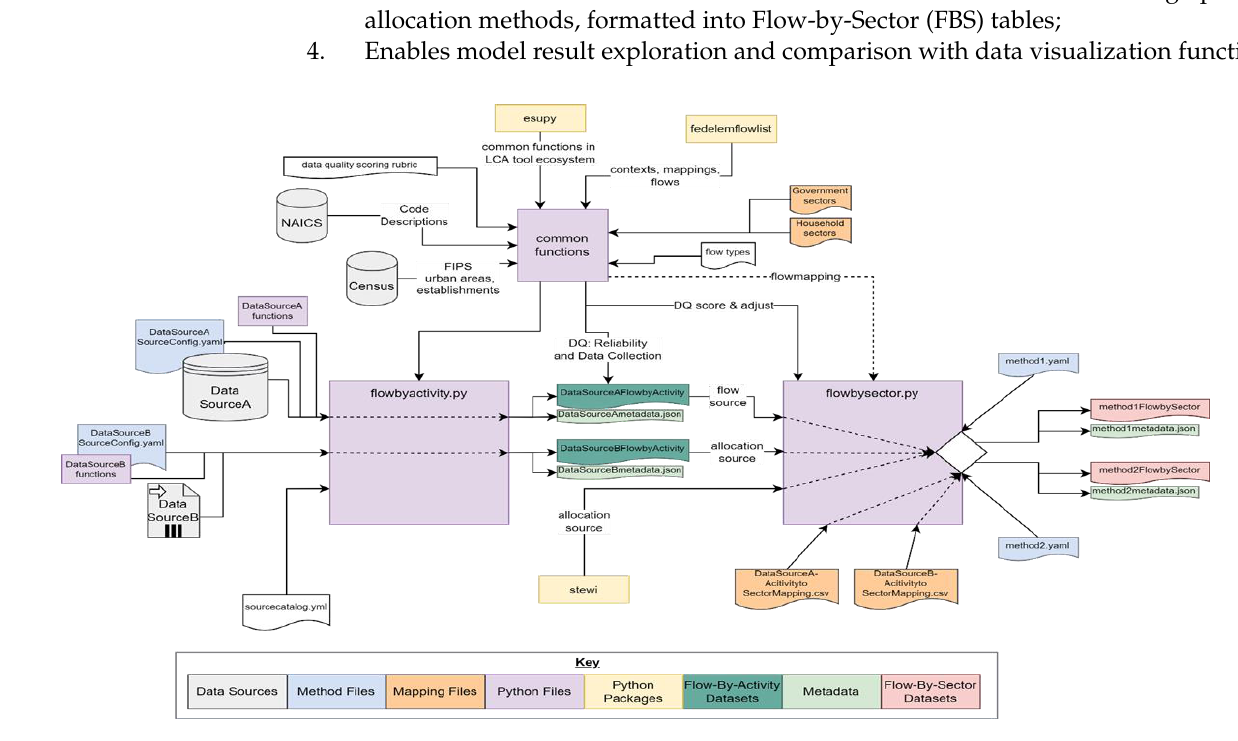
Figure 2. Schematic of the process to import and format source data as Flow-by-Activity (FBA) da- tasets, which are used to generate Flow-By-Sector (FBS) datasets.